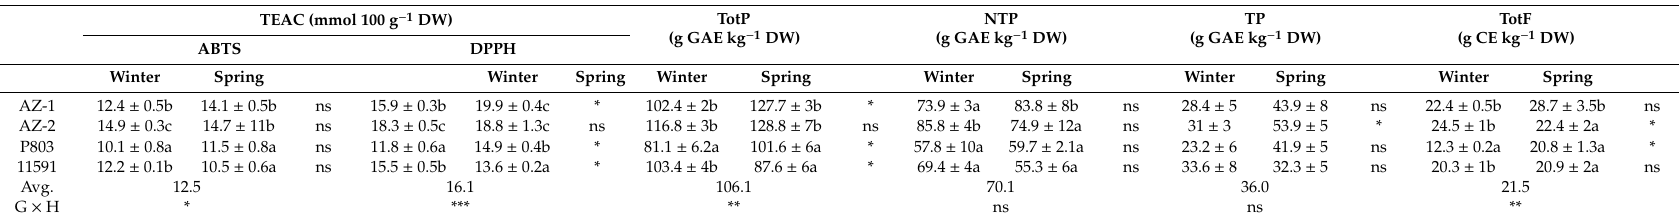
Table 2. Trolox equivalent antioxidant capacity (TEAC) by ABTS and DPPH methods, total phenolics (TotP), non-tannic phenolics (NTP), tannic phenolics (TP), total flavonoids (TotF) in twigs of the examined accessions of Parthenium argentatum harvested at 30 (winter) or 33 months (spring) after